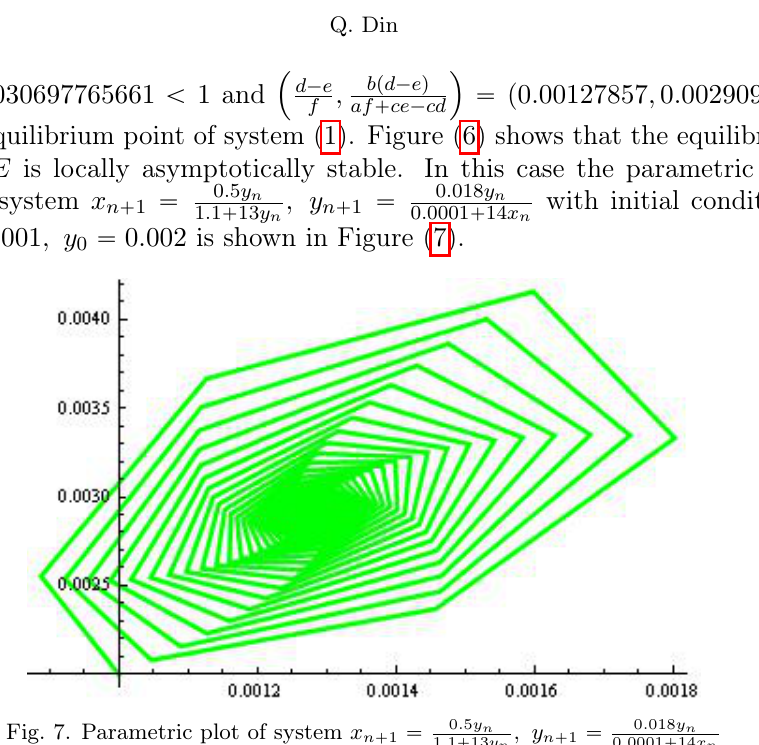
Fig. 7. Parametric plot of system x n ` 1